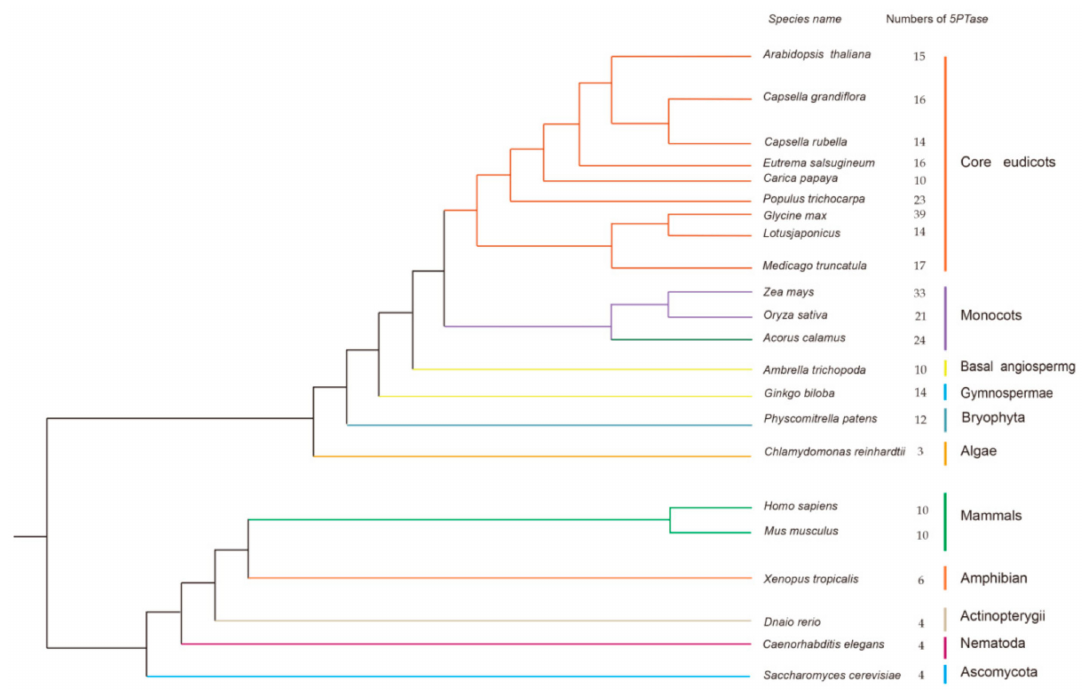
Figure 2. Phylogenetic relationships of species that were used in this study. The species tree was constructed based on the phylogeny of conserved nuclear genes [56–58]. The total number of 5PTase proteins found in the genome of each species is